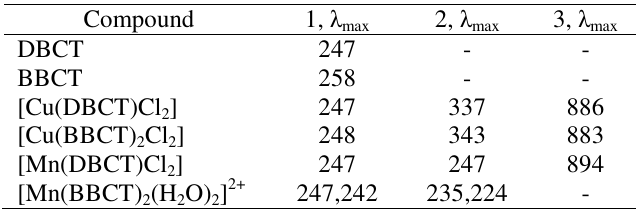
Table 3. Electronic spectral data (nm) of compounds